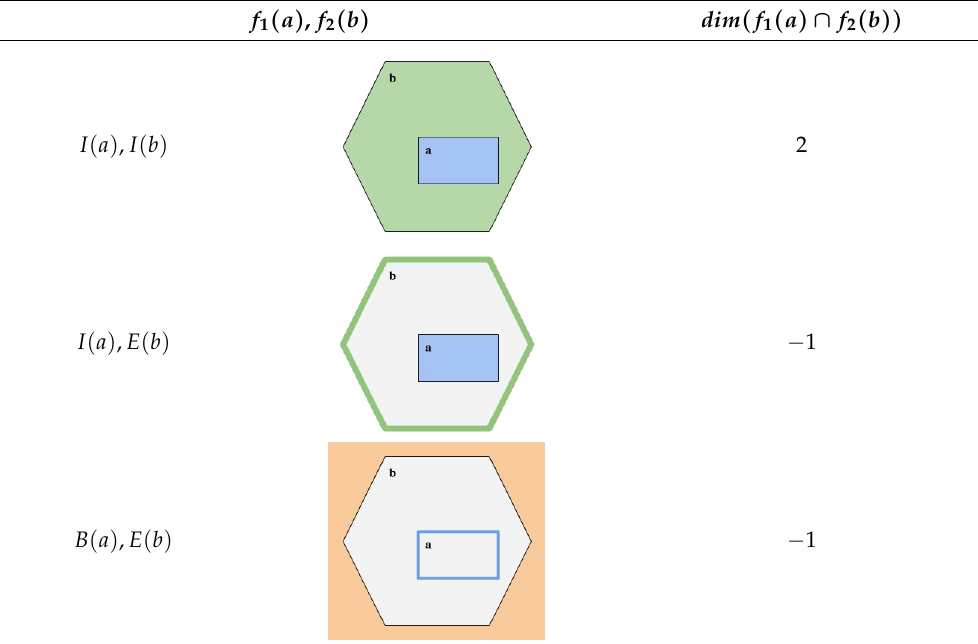
Table 1. Geometry features of components of within formula and dimension of their